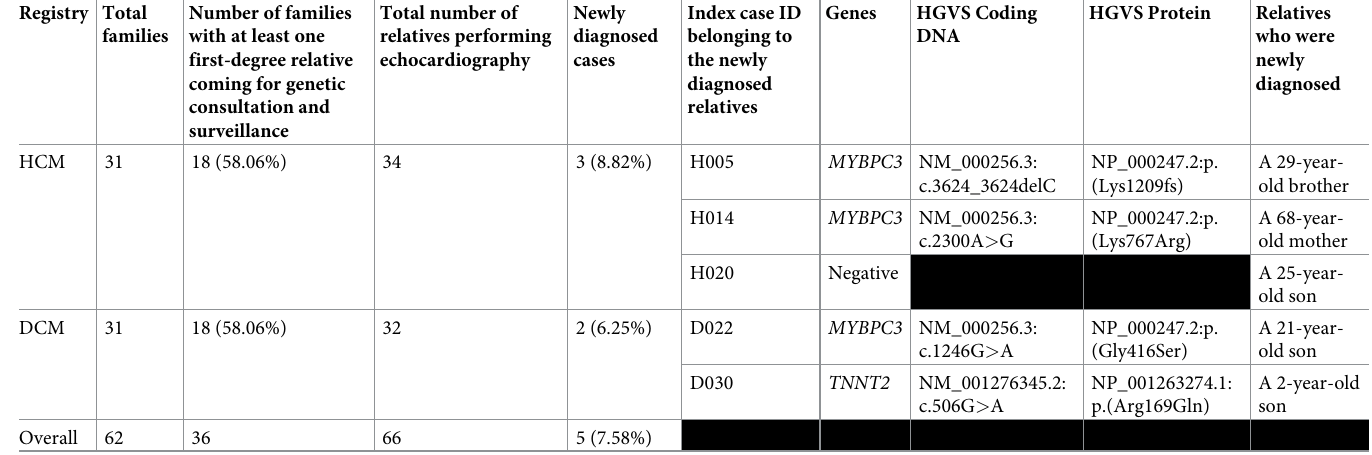
Table 2. Echocardiographic surveillance and the variants identified in asymptomatic first-degree relatives within six months following the first genetic consultation. Registry Total Number of families families with at least one first-degree relative coming for